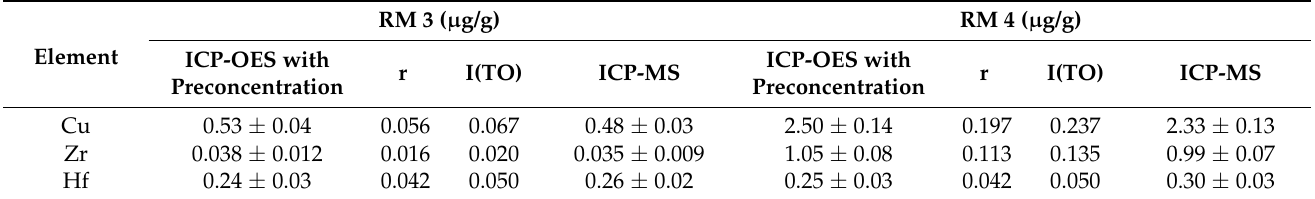
Table 8. Analytical results for analytes, using ICP-OES with preconcentration and ICP-MS (n = 2, P = 0.95). Sorption conditions: 0.1 mol/L HCl, C EDTA/NH3 = 50/2500 mg/L, m PTE = 0.1